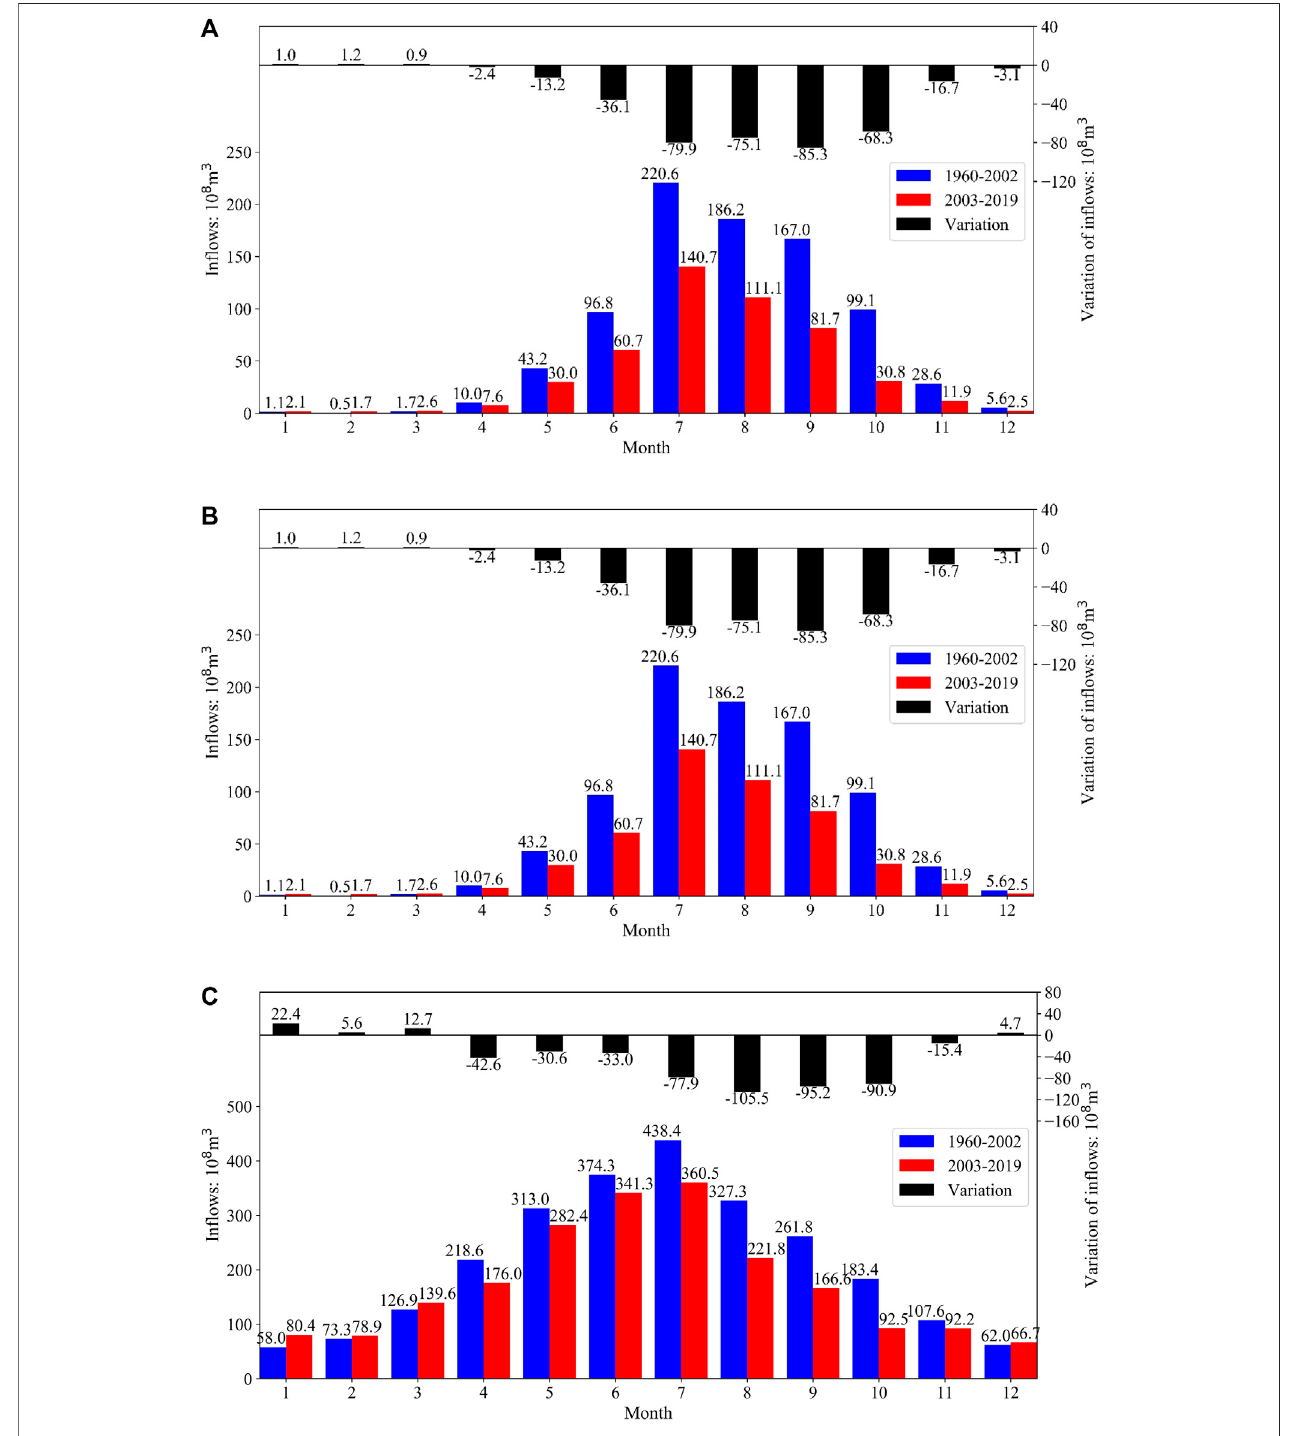
FIGURE 3 | In fl ow volumes and variations of Dongting Lake at different time periods (A) In fl ow from three channels; (B) In fl ow from four tributaries; (C) Total in fl ow.doc.